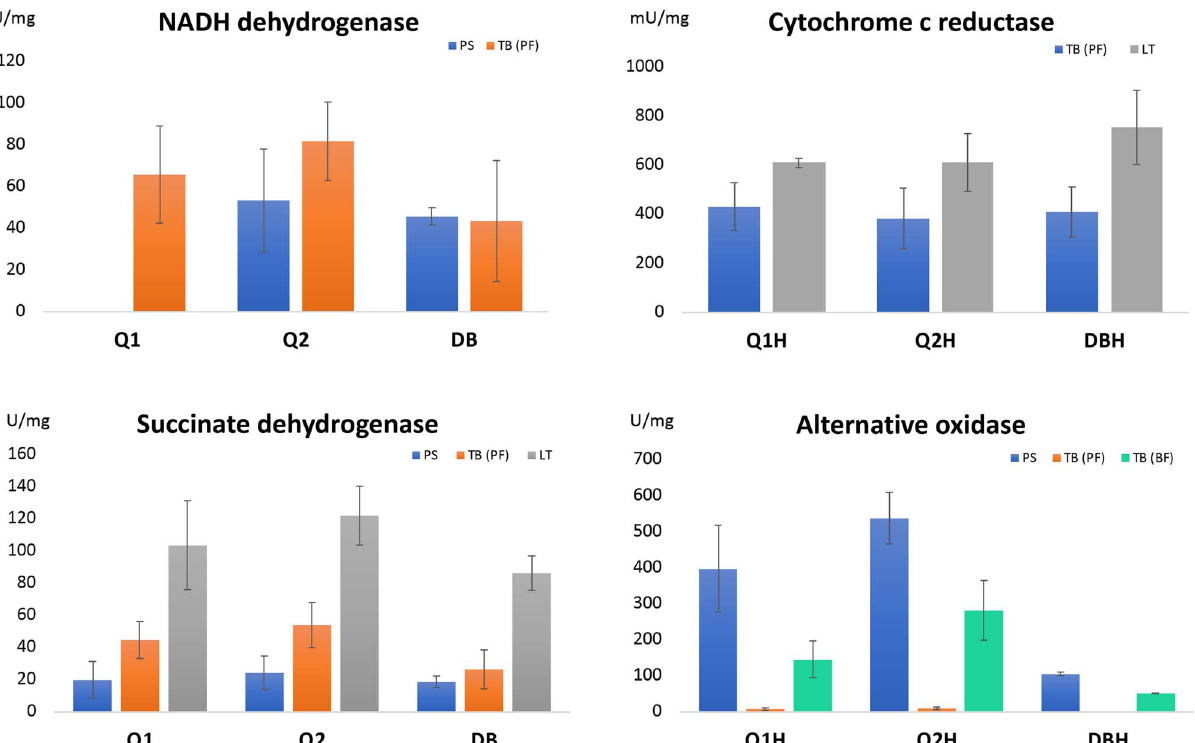
Figure 2. Respiratory chain enzyme activities with different substrates. PS – Phytomonas serpens , TB(PF) – Trypanosoma brucei (procyclic form), TB(BF) – Trypanosoma brucei (blood stream form), LT – Leishmania tarentolae . The unit (U) of appropriate activity is de fi ned as an amount of enzyme required for conversion of: 1 nMol of NADH/min for NADH dehydrogenase; 1 nMol of 2,6-dichlorophenolindophenol/min for succinate dehydrogenase; 1 l Mol of cytochrome c for cytochrome c reductase and 1 nMol of appropriate coenzyme Q/min for TAO. Presented data are an average of at least three independent biological experiments, each measured in triplicate. Only trypanosomatids with measurable corresponding activity in their mitochondria are